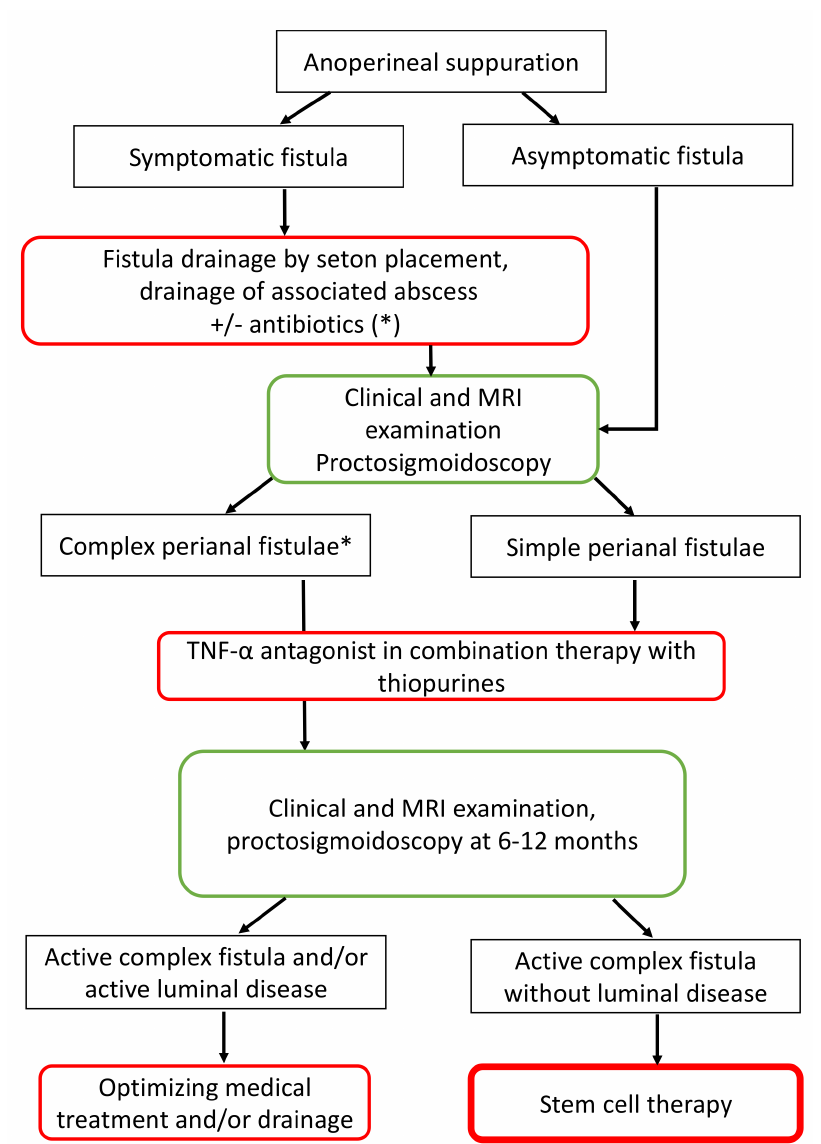
Figure 5. Algorithm for the management of perianal suppuration and complex fistula in Crohn’s disease including the place of stem cell therapy (*: ciprofloxacin and/or